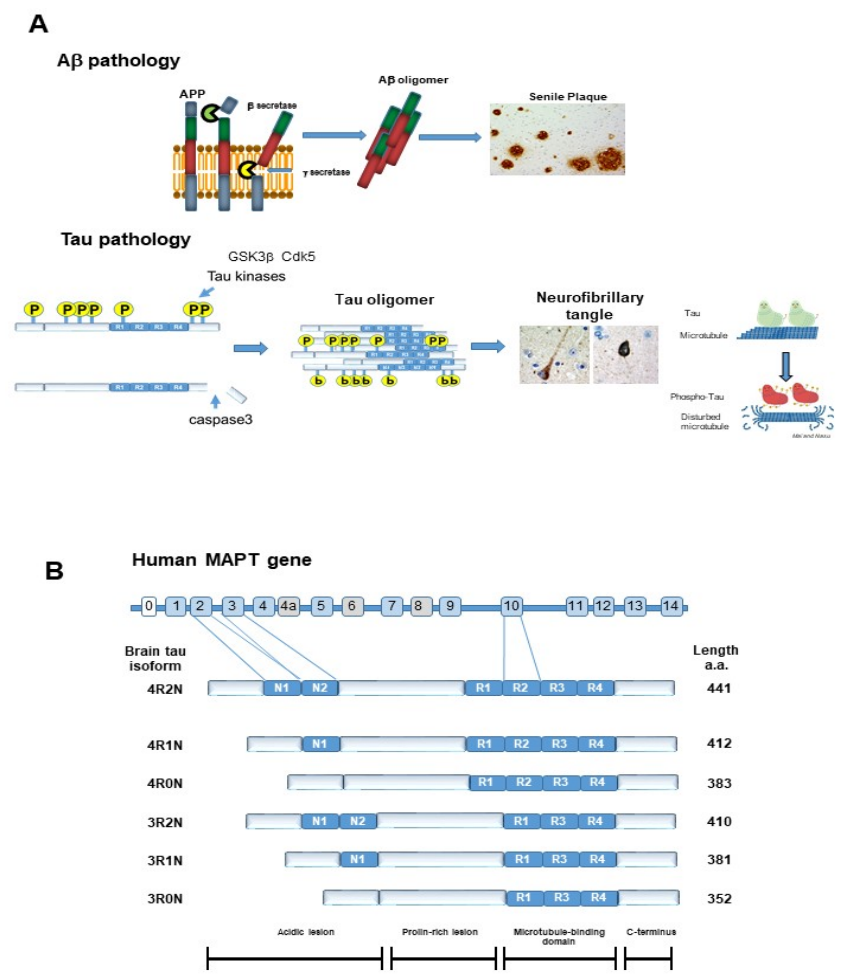
Figure 1. Pathological hallmarks of Alzheimer’s disease. ( A ) Amyloid β protein (A β ) was generated by cleaving amyloid precursor protein (APP) with β secretase and γ secretase. A β forms oligomers and finally forms senile plaques. Once tau protein is hyper-phosphorylated by tau kinases, including GSK3 β or cdk5, it detaches from the microtubule and forms aggregates, called tau oligomers. C terminal-truncated tau by caspase3 and N-terminal truncation accelerates tau aggregation. Tau oligomers are neurotoxic and further aggregation leads to neurofibrillary tangles (NFT). ( B ) Tau isoforms and phosphorylation epitopes. There are 6 tau isoforms according to the number of N terminal insertions and repeats of the microtubule binding domain: 4 repeat 2 N (4R2N), 4 repeat 1N (4R1N), 4 repeat 0N (4R0N), 3 repeat 2N (3R2N), 3 repeat 1N (3R1N), and 3 repeat 0N (3R0N).